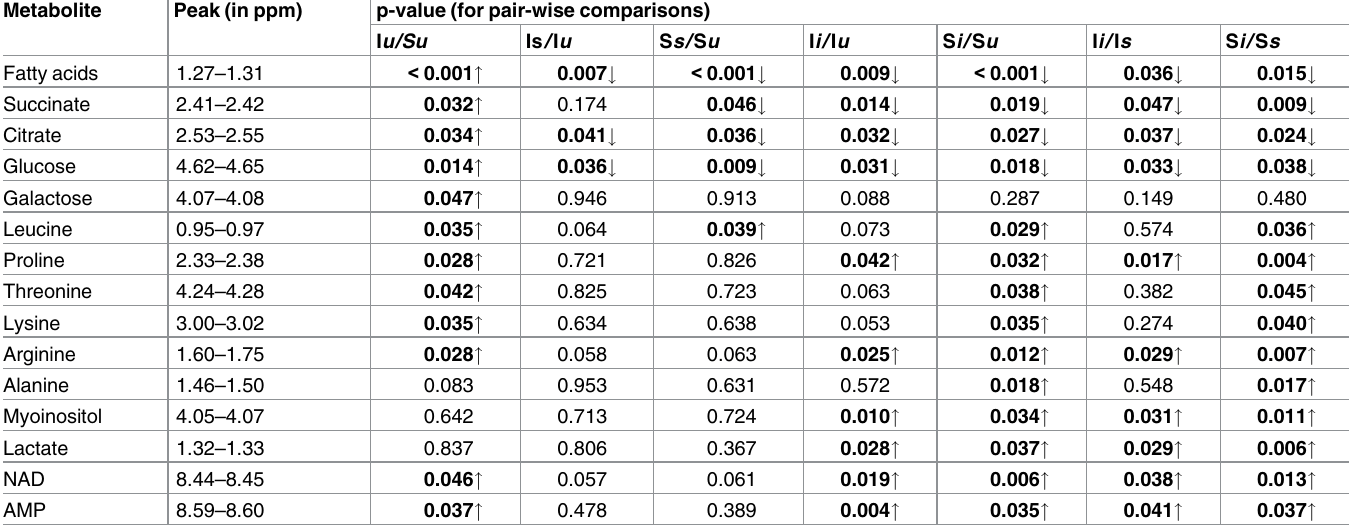
Table 2. Metabolites, their chemical shift values and BH corrected p-values for all pair wise comparisons, with significant metabolites (p < 0.05) for that particular comparison marked in bold. " (up) or # (down) arrows indicatesignificantincrease or decreasein concentration of metabolites respec- tively, in first treatment as comparedto second treatment for each